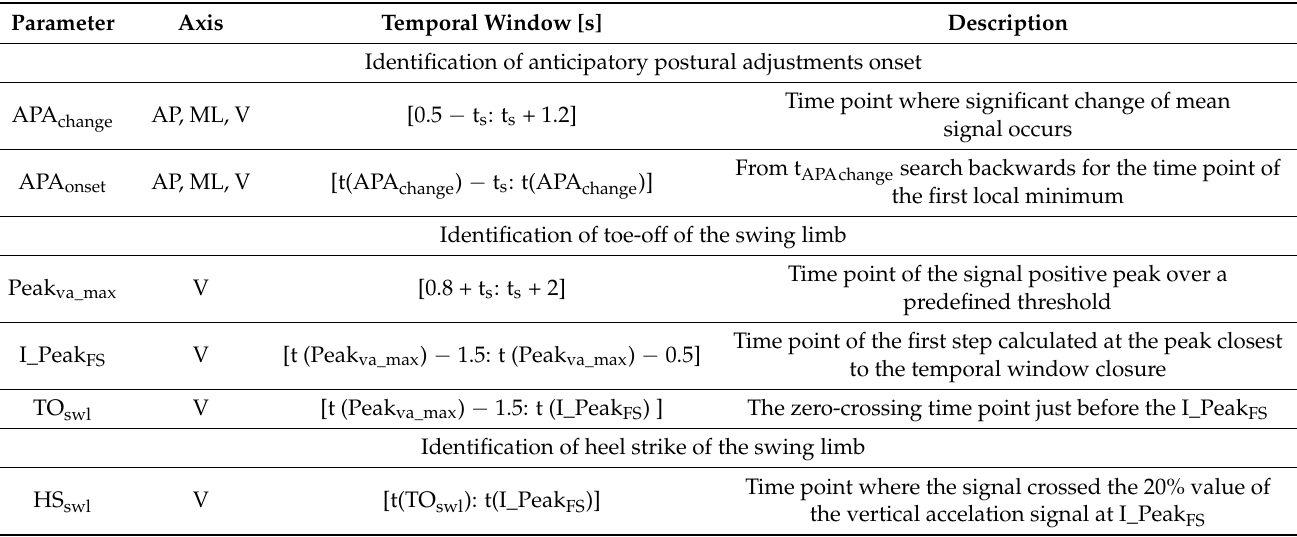
Table 1. Schematic summary of the main steps of the algorithm for the APA instants identification. Parameter Axis Temporal Window [s] Description Identification of anticipatory postural adjustments